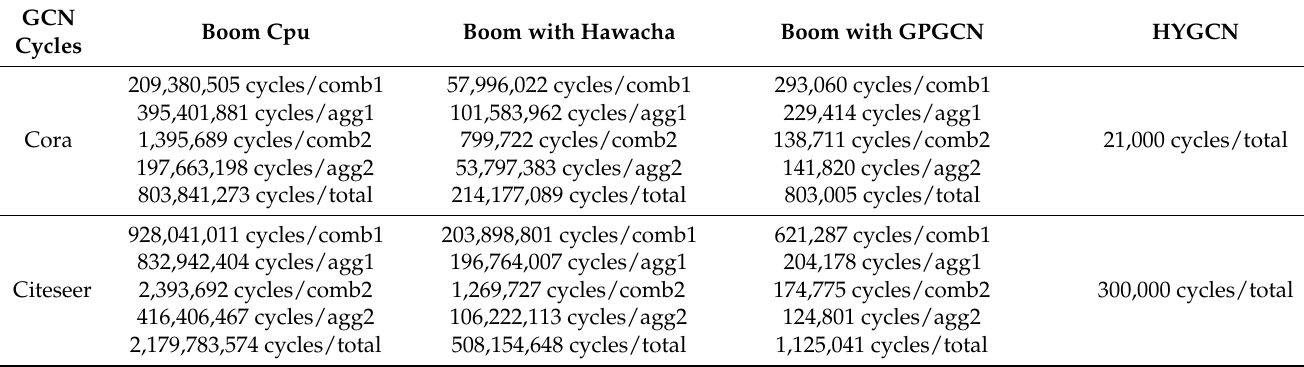
Table 8. The GCN execution latency of different hardware with different